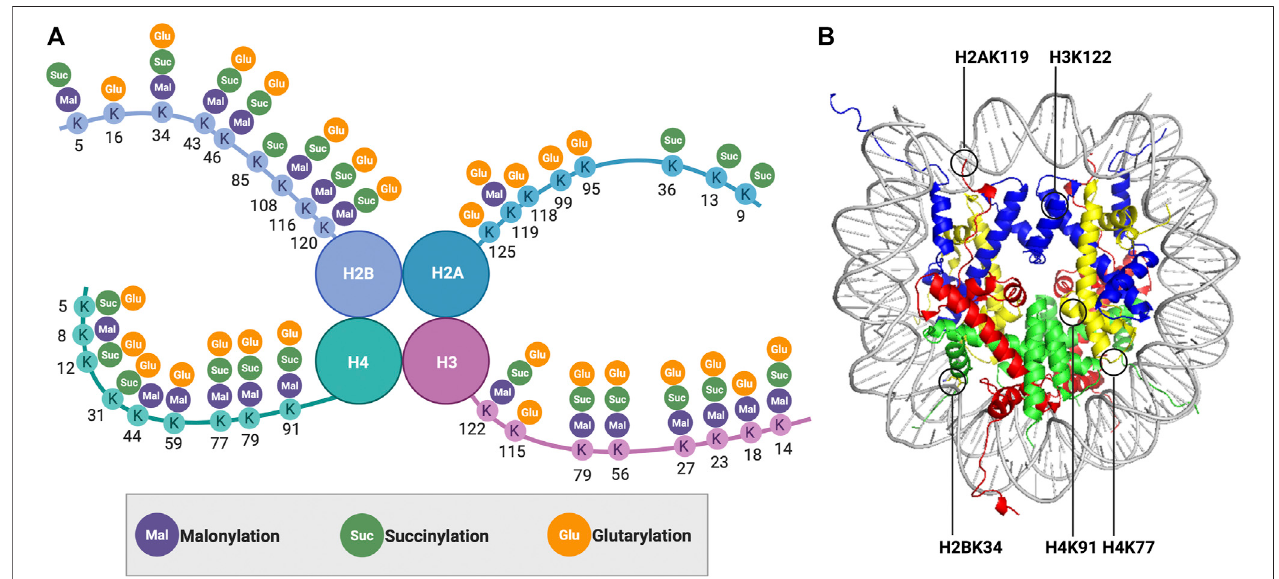
FIGURE 1 | (A) Distribution of lysine malonylation, lysine succinylation, and lysine glutarylation on histones. (B) Nucleosomal localization of the modi fi ed histone lysine residues discussed in this